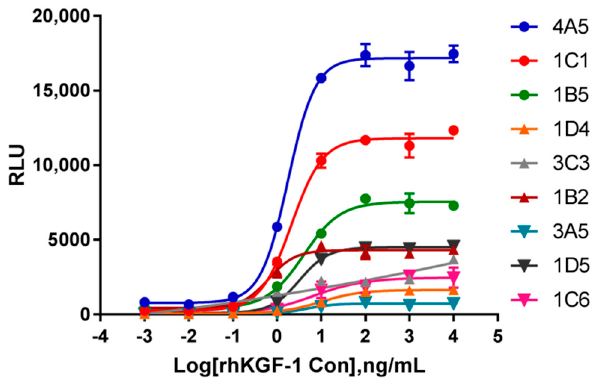
Figure 1. The establishment of HEK293-Luc cell lines responsive to rhKGF-1. The nine clones of single-cell dilutions of HEK293-Luc cells bearing luciferase and human KGFR2 IIIb were evaluated by their luciferase activity with rhKGF-1 stimulation (initial concentration of 10,000 ng/mL, dilution ratio of 1:10). The curves were calculated in a four-parameter model. RLU = Relative Luciferase Units. The mean ± SD is shown on each curve.